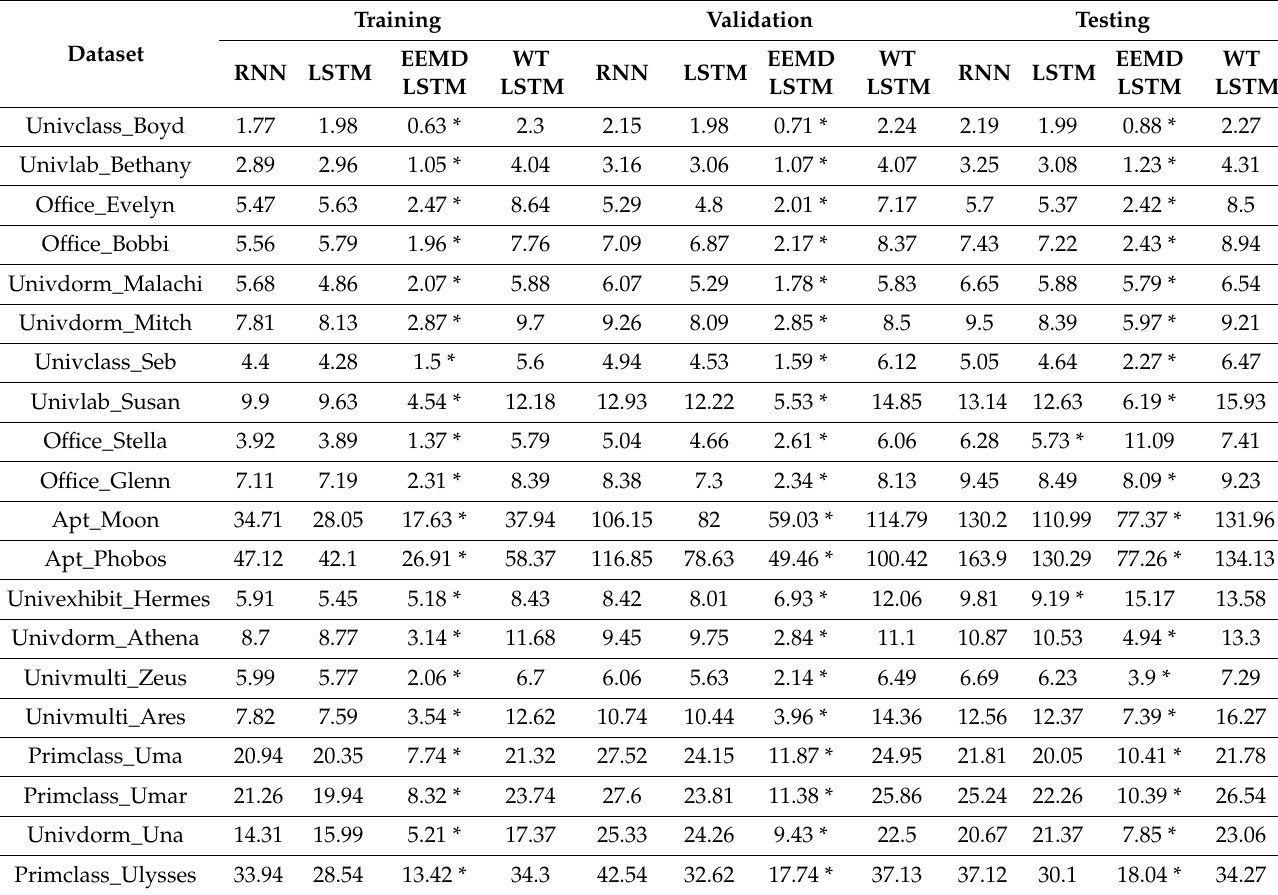
Table 16. Comparison of algorithms based on MAPE (%) using time series